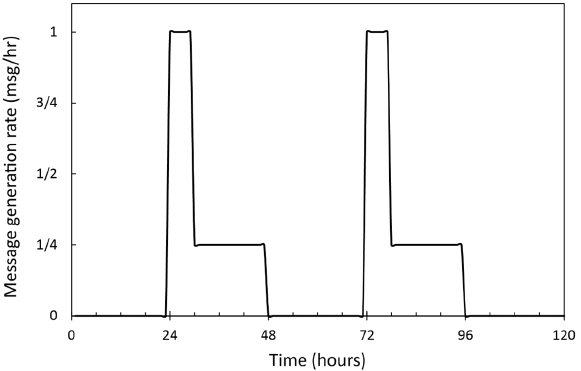
Figure 17. Message generation rate at each source node for investigating the impact of fluctuating data traffic on inferring node burden from buffer information.